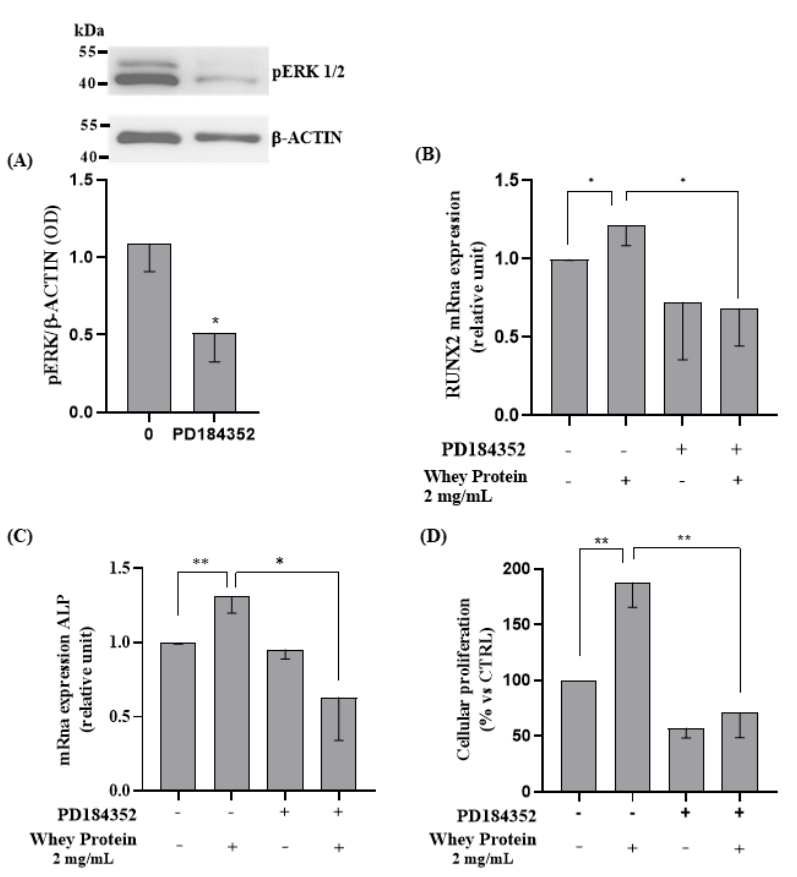
Figure 5. ERK1/2 inhibition role in WP-induced proliferation and differentiation on Saos-2 cells. Semi-confluent cultures of human osteoblast-like cells (Saos-2) were pretreated with PD184352 for 1 h, then incubated with 2 mg/mL of WP for 24 h. Cell proteins were analyzed by Western blotting, with antibodies specific to pERK1/2 and β -actin ( A ). Then, mRNA expression levels of ( B ) RUNX2 and ( C ) ALP were measured by RT-PCR. Data were analyzed using the 2 −ΔΔ Cq method and normalized to β -actin. Cell proliferation ( D ) was determined by counting the number of cells in each well. Data are represented as mean ± SD. Statistical analysis: * p < 0.05, ** p < 0.01 (Student’s t-test). Abbreviations: RUNX2 = runt-related transcription factor 2; PD184352 = MEK/ERK inhibitor; ALP = alkaline phosphatase.